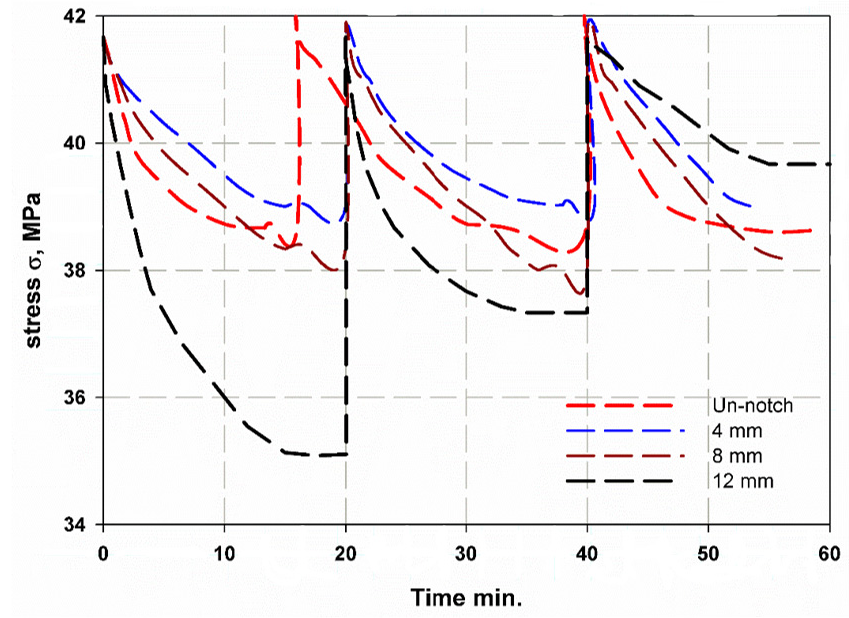
Figure 13. Relaxation stress and time curve of CFRP.